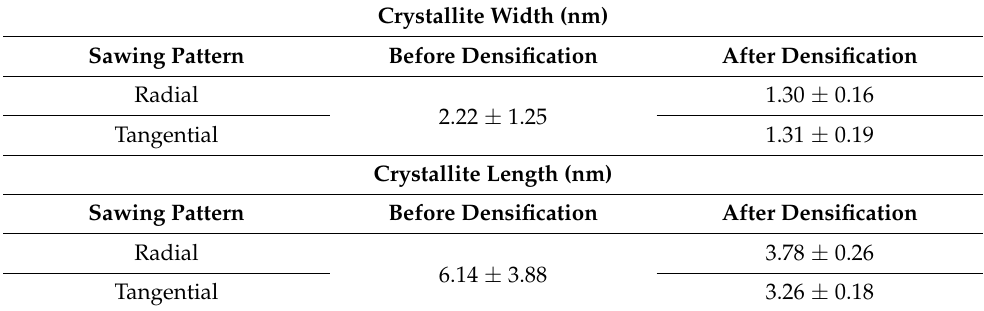
Table 1. Changes in crystallite dimensions in radial and tangential boards after